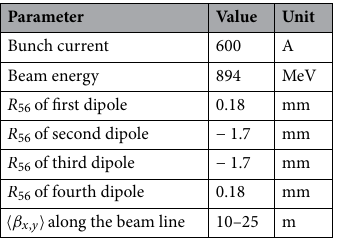
Table 2. Table of parameters used for FERMI transfer line.